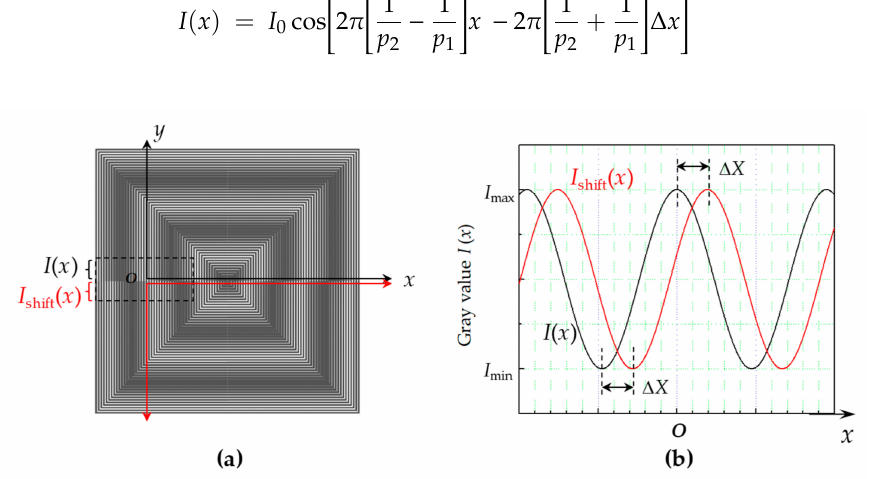
Figure 3. ( a ) Moir é fringe pattern with a small misalignment by ∆ x ( (cid:44) 0), which will lead to a moir é shift ( ∆ X ) in the x -direction between the two rows of moir é fringes; ( b ) the moir é shift can be determined by detecting the phase di ff erence between two digital moir é fringes, i.e., I ( x ) and I shift ( x